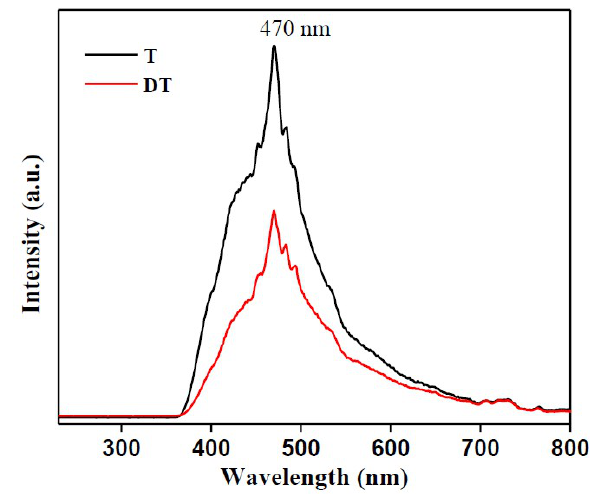
Figure 6. PL spectra of T and DT samples.